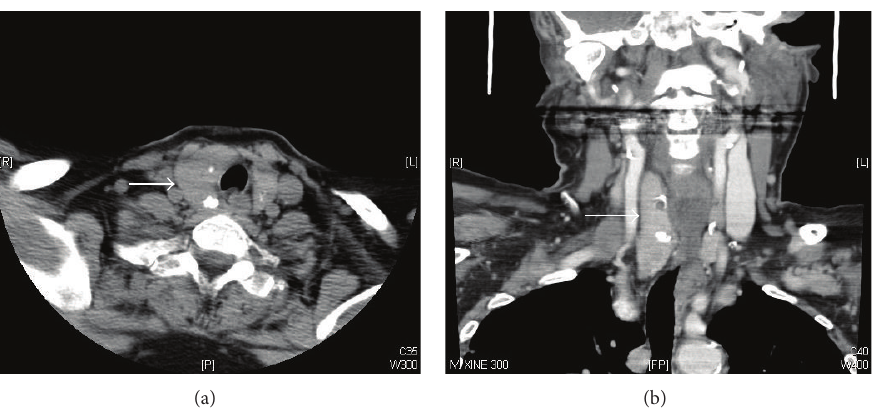
Figure 1: Computed tomography of neck showing diffuse enlargement of right lobe of thyroid, came out as papillary follicular cell variant thyroid carcinoma pT2N1.